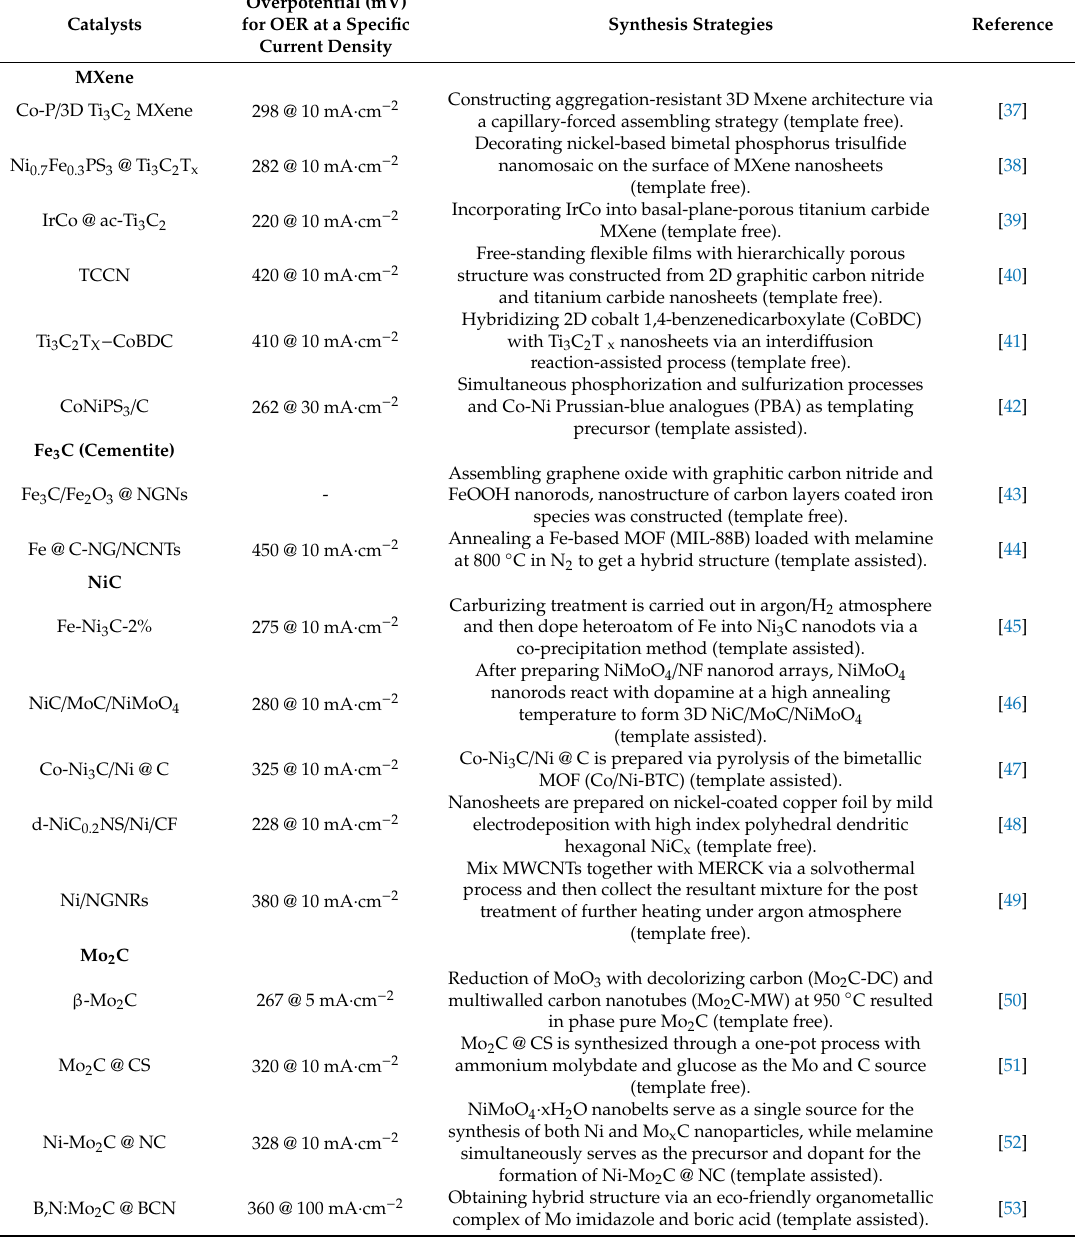
Synthesis Strategies